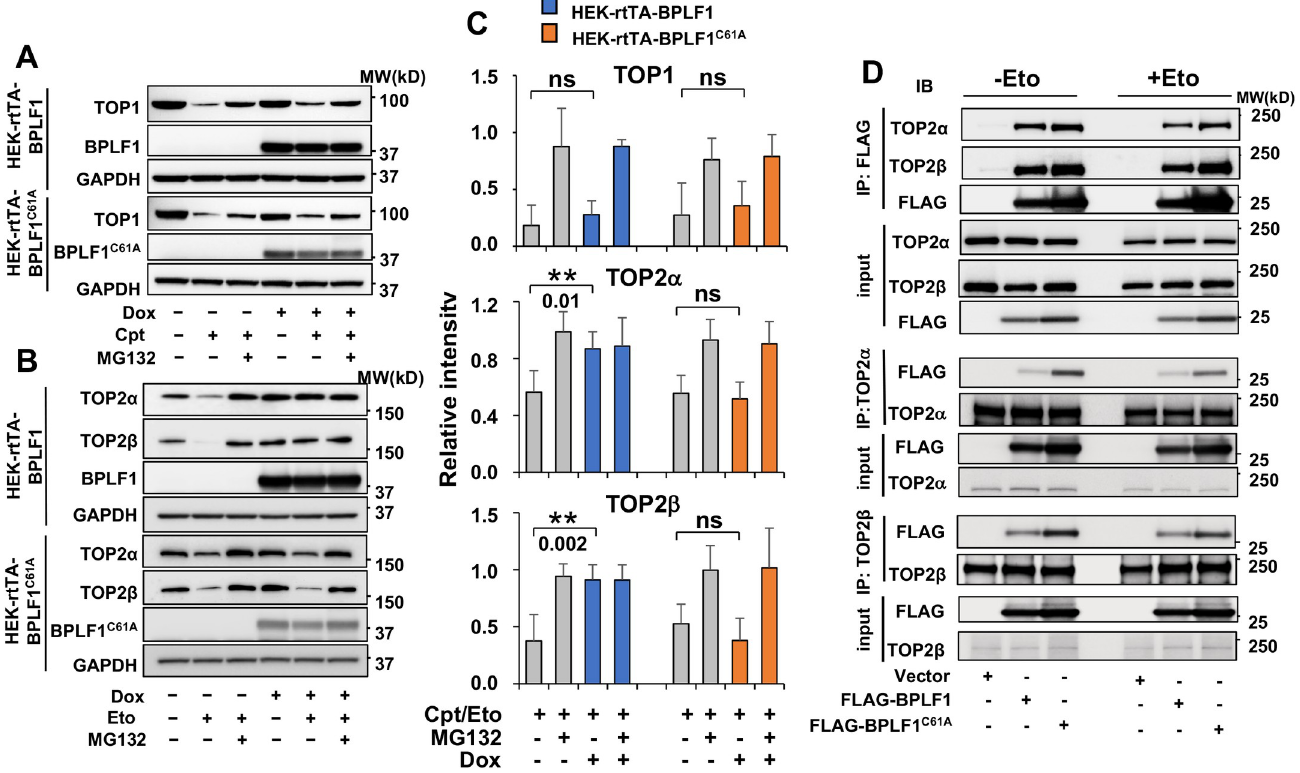
Fig 1. BPLF1 selectively binds to TOP2 and inhibits the degradation of TOP2 in cells treated with topoisomerase poisons. HEK-293T cell expressing inducible FLAG-BPLF1 or FLAG-BPLF1 C61A were seeded into 6 well plates and treated with 1.5 μ g/ml Dox for 24 h. After treatment for 3 h with 5 μ M of the TOP1 poison Camptothecin (Cpt) or 6 h with 40 μ M of the TOP2 poison Etoposide (Eto) with or without the addition of 10 μ M MG132, protein expression was analyzed in western blots probed with the indicated antibodies. GAPDH was used as the loading control. (A) Representative western blots illustrating the expression of TOP1 in control and Cpt treated cells. The proteasome-dependent degradation of TOP1 induced by the treatment was not affected by the expression of BPLF1 or BPLF1 C61A in Dox treated cells. (B) Representative western blots illustrating the expression of TOP2 α and TOP2 β in Etoposide treated cells. Expression of BPLF1 protected TOP2 α and TOP2 β from Etoposide-induced proteasomal degradation while BPLF1 C61A had no appreciable effect. (C) The intensity of the TOP1, TOP2 α and TOP2 β specific bands in 5 (TOP1) or 6 (TOP2 α and TOP2 β ) independent experiments was quantified using the ImageJ software. The data are presented as intensity of the bands in Cpt/Eto treated samples relative to untreated control after normalization to the GAPDH loading control. Statistical analysis was performed using Student’s t-test. �� P � 0.01; ns, not significant. (D) HEK293T cells transfected with FLAG-BPLF1, FLAG-BPLF1 C61A , or FLAG-empty vector were treated with 40 μ M Etoposide for 30 min and cell lysates were either immunoprecipitated with anti-FLAG conjugated agarose beads or incubated for 3 h with anti-TOP2 α or TOP2 β antibodies followed by the capture of immunocomplexes with protein-G coated beads. Catalytically active and inactive BPLF1 co-immunoprecipitate with both TOP2 α and TOP2 β in untreated and Etoposide treated cells (upper panels). Conversely, TOP2 α (middle panels) and TOP2 β (lower panels) interact with both catalytically active and inactive BPLF1. Representative western blots from one of two independent experiments where all conditions were tested in parallel are